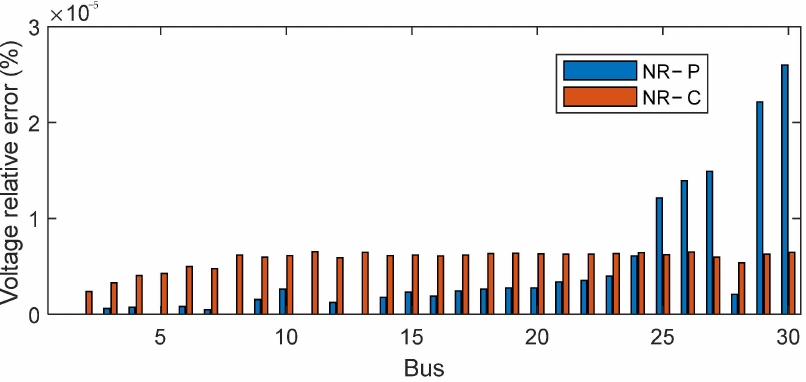
Figure 2. Bus voltages relative errors of NR-P and NR-C compared to MATPOWER.